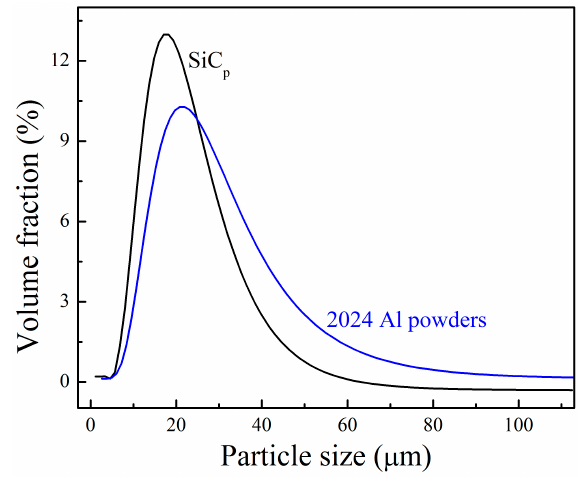
Figure 2. Size distributions of the 2024Al powders and SiC p .